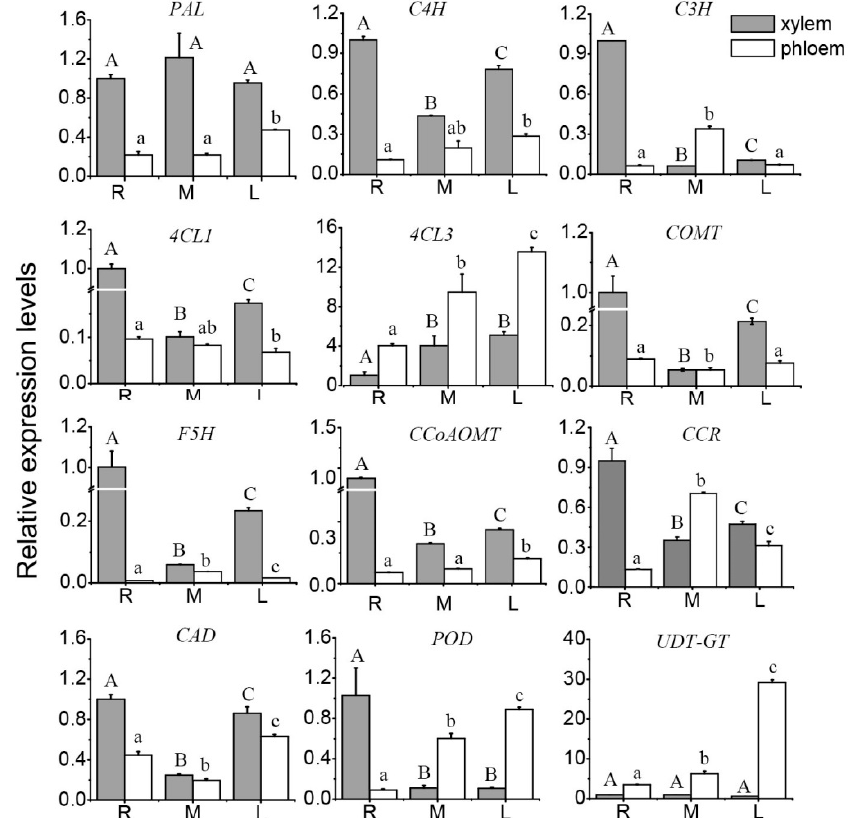
Figure 3. Relative expression levels of genes involved in the lignin biosynthesis pathway in the xylem and phloem of ramie at three periods. R: fast-growing period; M: maturation period; L: late maturation period; PAL : phenylalanine alanine ammonia-lyase; C4H : cinnamate-4-hydroxylase;